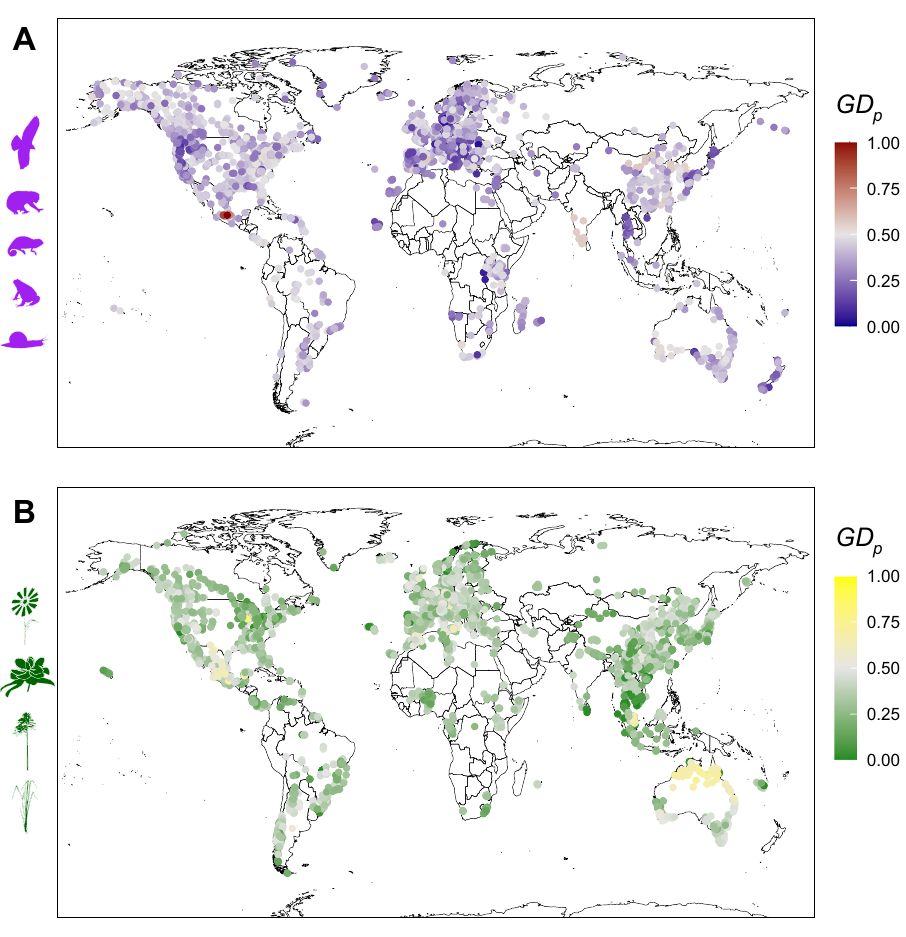
Fig. 1 Global distribution of population genetic diversity (GDP) across the animal and the plant kingdoms. Our survey encompasses 8356 local animal ( A ) and plant ( B ) populations throughout the world and for which genetic diversity (measured as multilocus expected heterozygosity) has been assessed. Source data are provided as a Source Data fi le.